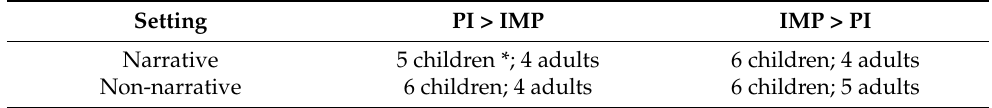
Table 1. Distribution of participants across experimental settings. Setting